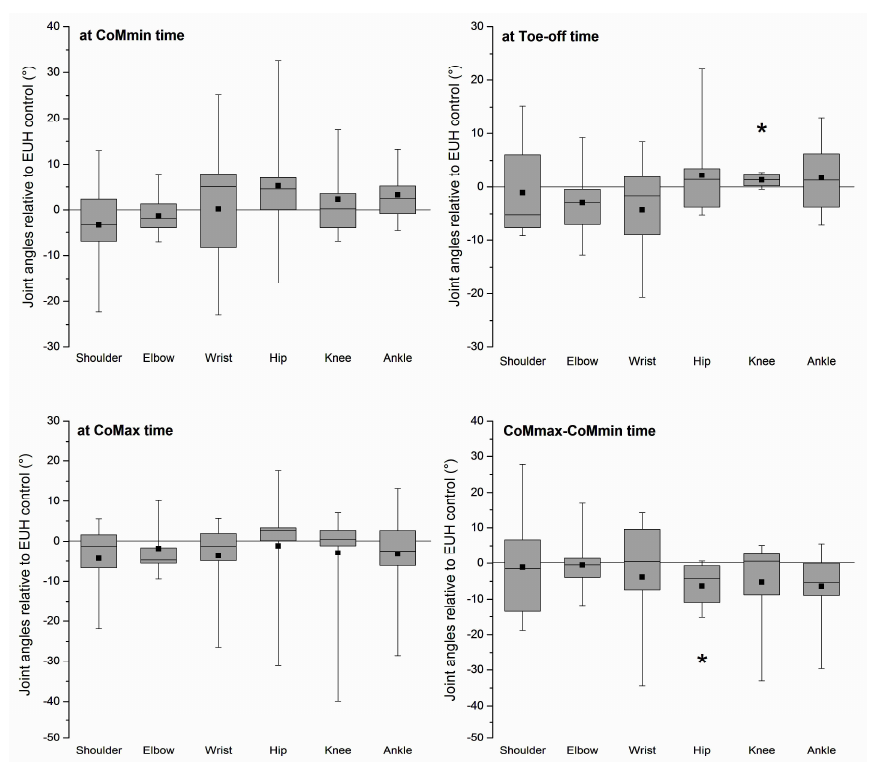
Figure 3. Box plots of joint angles changes at key time points of 3PS in DEH relative to EUH condition. The black square near the centre of each box represents the mean difference from EUH for each time point. * denotes a significant difference between EUH and DEH ( p <